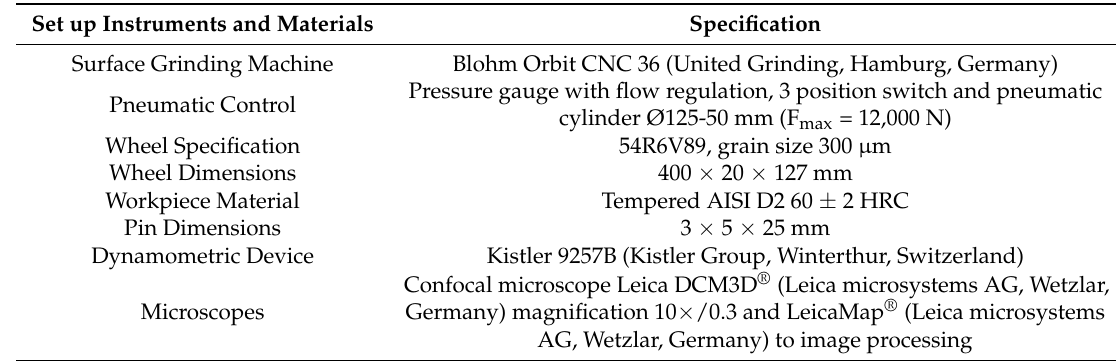
Table 1. Set up of pin-on-disk tests and surface analysis.